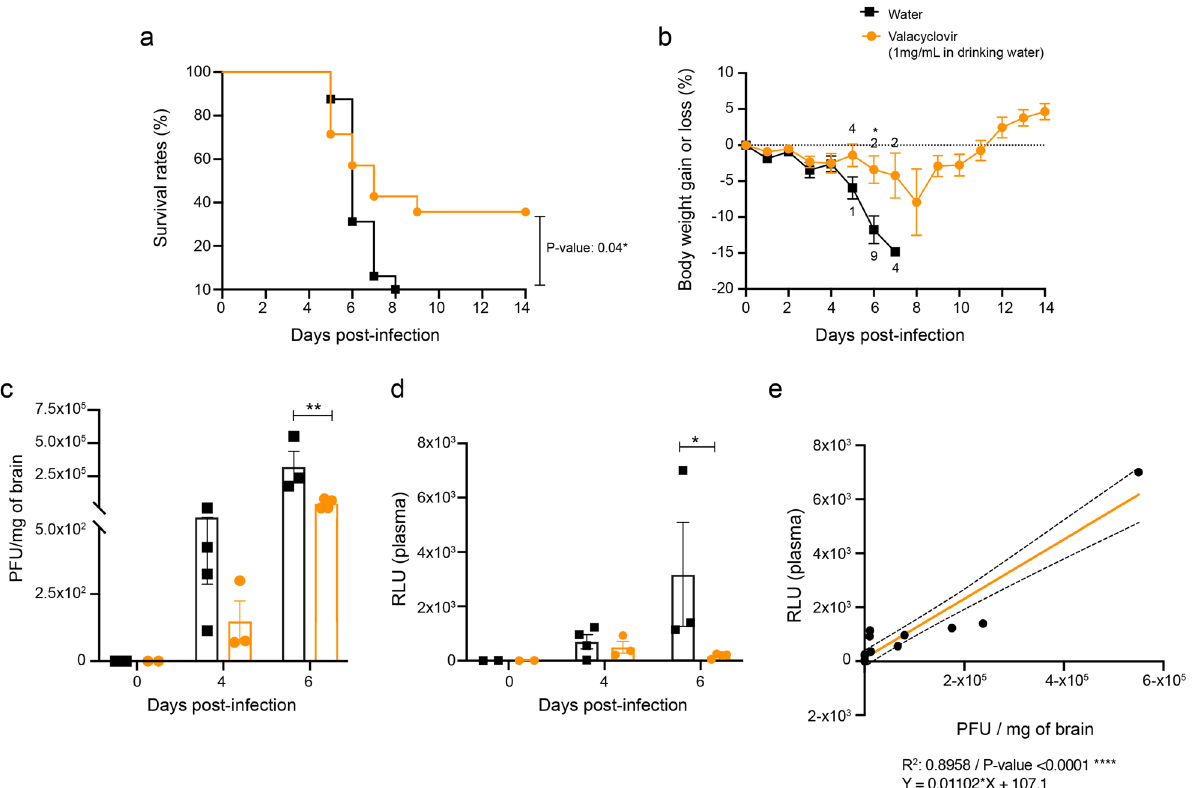
Figure 6. Luciferase activity-based rapid assessment of valacyclovir treatment against HSE. The effect of valacyclovir (VACV) administration was studied in 6-week -old male BALB/c mice infected intranasally with 2500 PFU of HSV-1 strain H25 in 20 μL of minimal essential medium. Infected mice were treated with VACV (1 mg/mL in drinking water) from day 3 post-infection and on. The differences in survival rates ( a ) and percentage of body weight changes ( b ) were evaluated for 14 days post-infection, using Log-Rank (Mantel– Cox) and Holm-Sidak multiple comparison t-tests, respectively. The digits along the curves ( b ) correspond to the numbers of dead mice on the indicated day. Viral titers in the CNS (PFU/mg of brain) ( c ) and luminescence (RLU) ( d ) in plasma samples of infected mice were measured on days 0, 4 and 6 post-infection. Results represent the means ± SEM. Statistical differences between groups (Control group: black squares or bars; VACV: orange circles or bars) were obtained using two-way ANOVA with Sidak’s multiple comparisons test. rHSV-1 titers in brains and Gluc activities in plasma ( e ) were analyzed with a simple linear regression. The regression equation, confidence intervals (black dashed lines), R 2 and P-value are shown in the